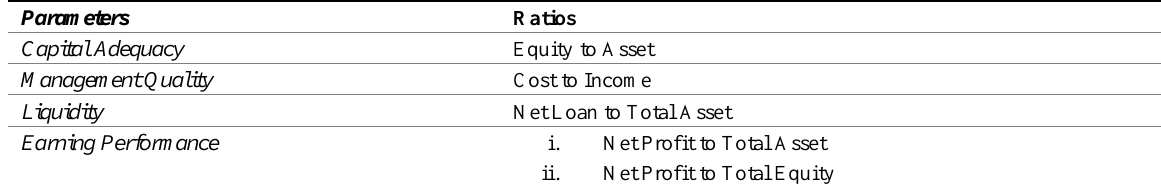
Table 2: CAMEL parameters